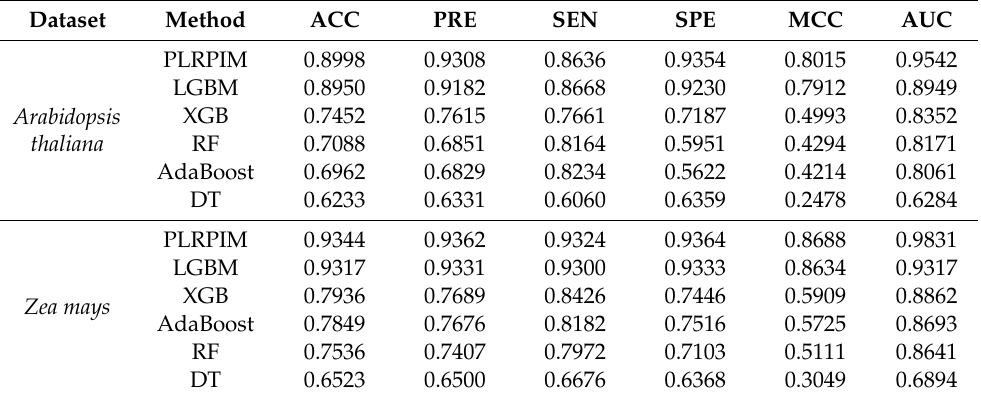
Table 4. Predictive performance of classifiers and the proposed